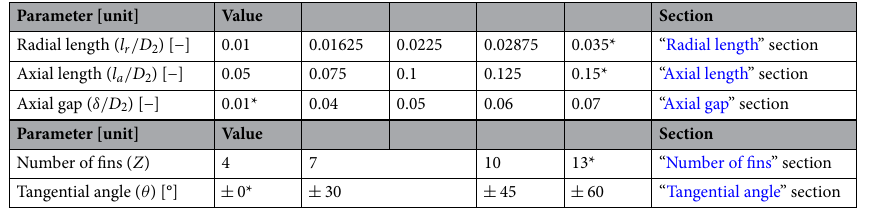
Table 2. Variable range of each design parameter for the anti-stall fin (ASF). *Reference